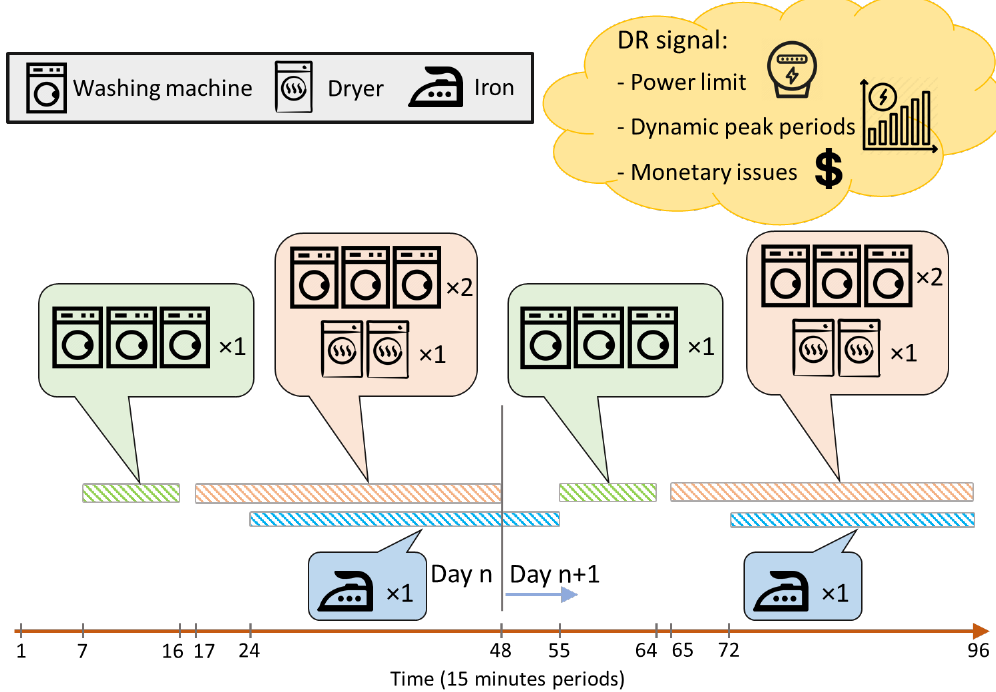
Figure 1. Sequential tasks operation over two working days.